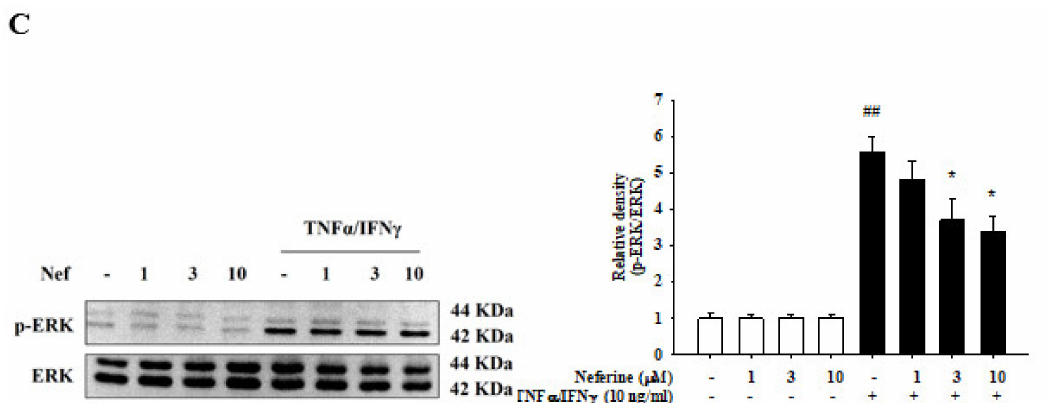
Figure 4. Neferine reduced TNF- α /IFN- γ -induced JNK ( A ), p38 ( B ), and ERK ( C ) activation in human keratinocyte (HaCaT) cells. Human keratinocyte (HaCaT) cells were pretreated with different concentrations of neferine (1, 3, and 10 µ M) for 20 min, and then the cells were treated with TNF- α /IFN- γ (10 ng/mL) for 30 min. Western blots were analyzed quantitatively. Values represent the mean ± SEM from three independent experiments. ## p < 0.01 compared with the no-treatment condition; * p < 0.05 and ** p < 0.01 compared with the TNF- α /IFN- γ treatment